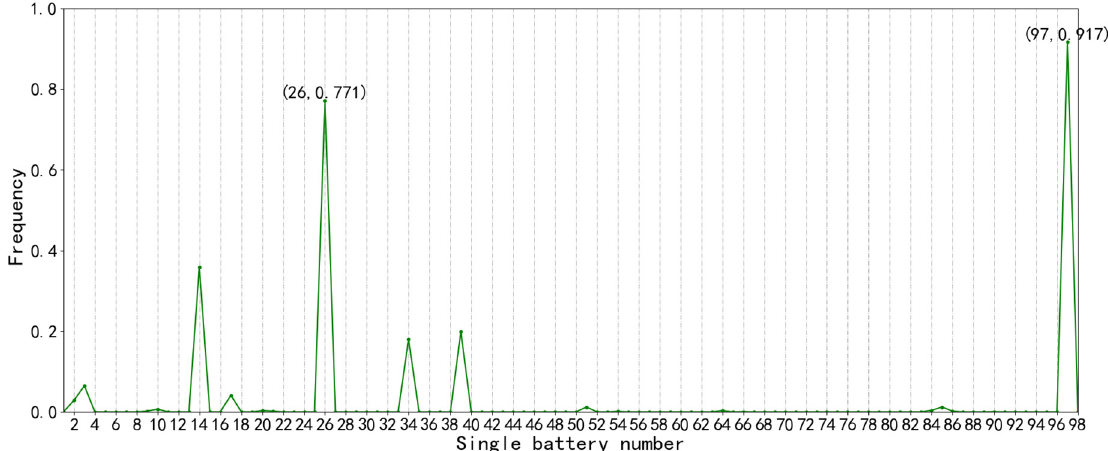
Figure 17. Frequency graph of sub-health state type II of single cells.